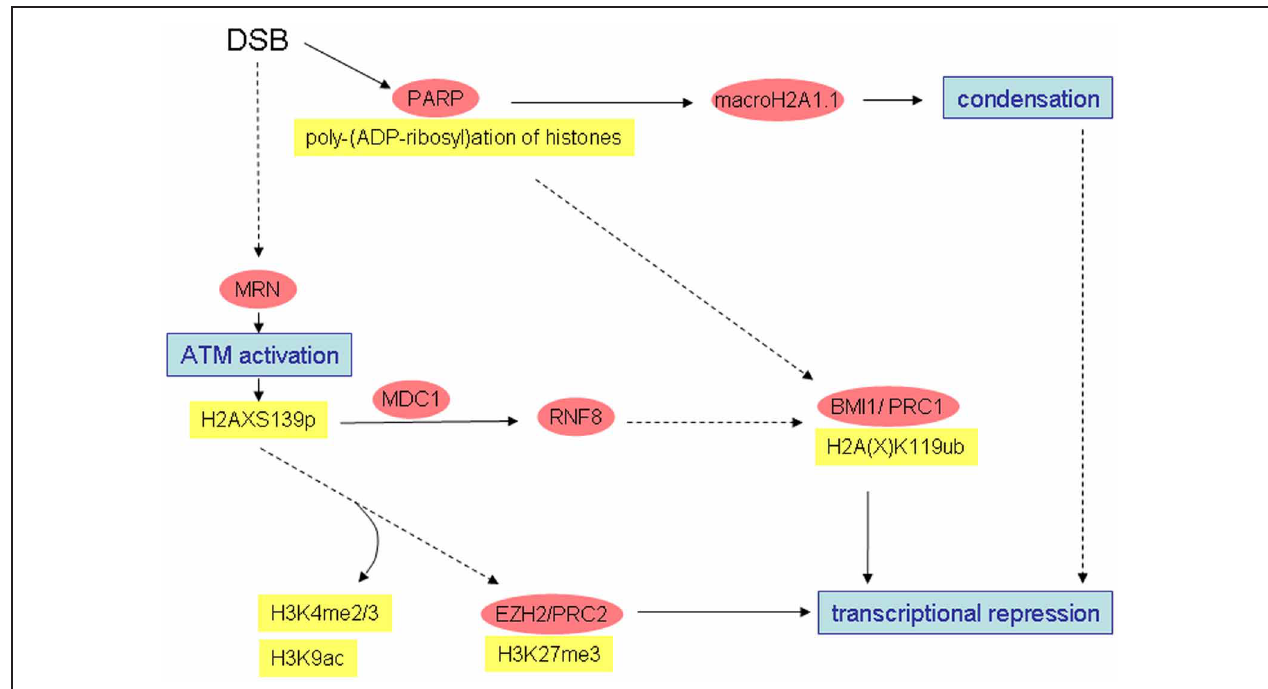
FIGURE 2 | Simplified overview of radiation-induced alterations possibly leading to chromatin condensation and transcriptional repression. Well-characterized interactions and causal relationships are depicted by solid lines, less well characterized interactions and relationships by broken